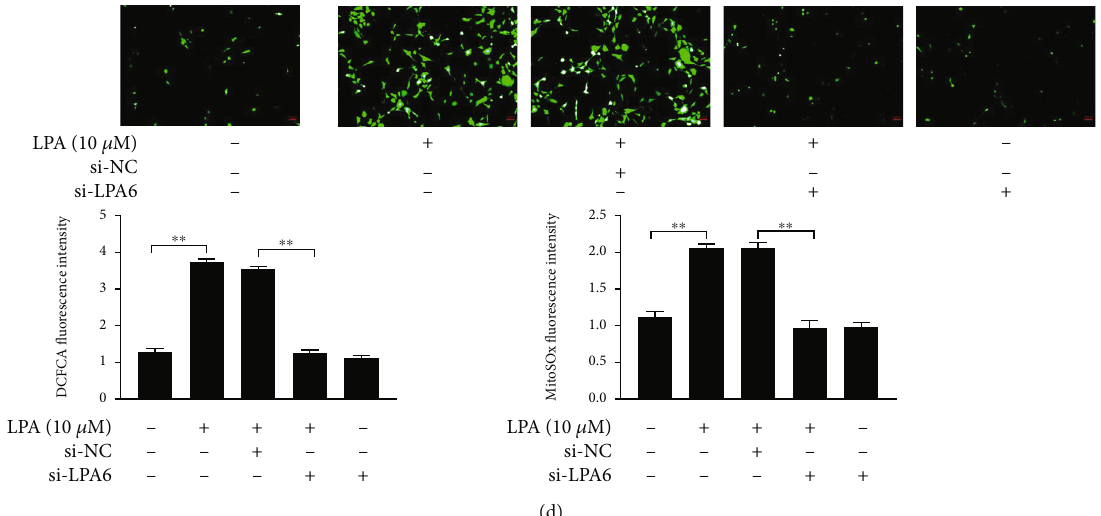
Figure 7: LPA6 mediates LPA-induced spinal cord neuron apoptosis, DNA damage, and oxidative stress. (a, c) The expression of LPA6 and DNA damage-related proteins in spinal cord neurons were measured by western blotting. (b) The apoptotic ratio was detected by fl ow cytometry. (d) Quantity analysis of intensity of the DCFDA staining and MitoSOx staining. Asterisks indicate statistical signi fi cance ( ∗ p < 0 : 05 , ∗∗ p < 0 : 01